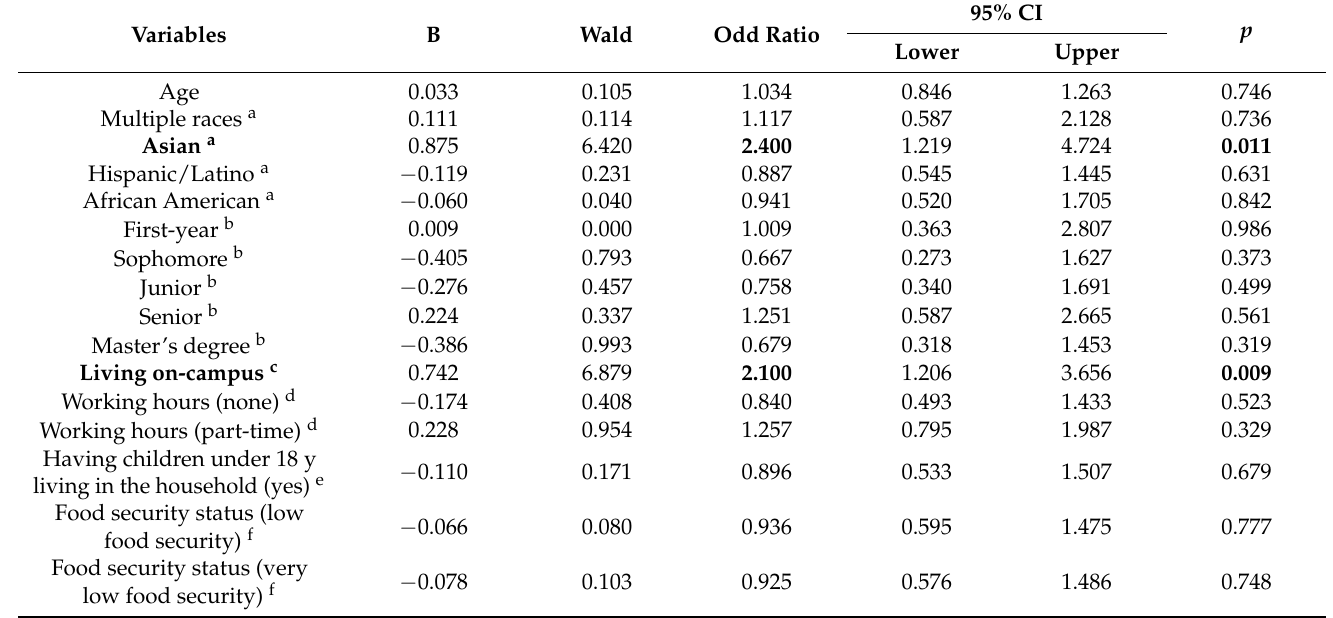
Table 5. Summary of Logistic Regression Predicting Food Pantry Awareness by Demographic Factors and Food Security